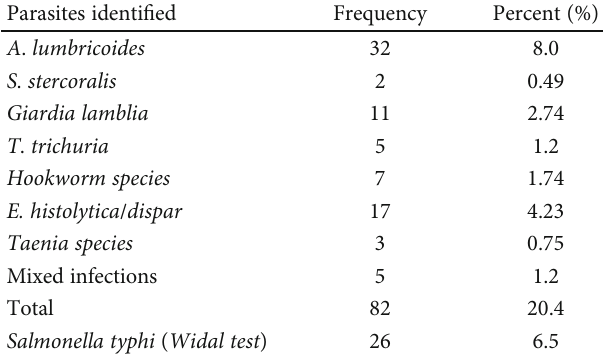
Table 2: Prevalence of intestinal parasites and Salmonella of food handlers working in catering establishments in Dawuro Zone, South-Western Ethiopia, March to July 2019 ( N = 402 ) ( N = 82 and N = 26